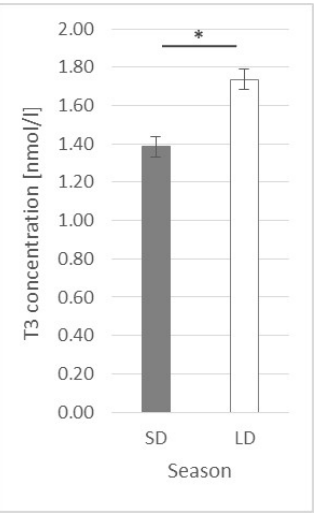
Figure 13. Plasma triiodothyronine (T3) concentration—comparison between the short-day (SD) and long-day (LD) seasons at a 0 h time point; *—indicates p ≤ 0.05, according to Student’s t -test ( n = 24).